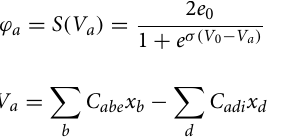
M2 receptor subtype 9–11,43 . Meanwhile, the SC population in the brainstem sends excitatory outputs to the TRC and IN populations via glutamatergic neurotransmitter 40,41 . The synaptic interconnections between the thalamus and the cortex modules conform to the classical results as presented in the literatures 26,36,37 , i.e., all the popula- tions of TRC, IN and TRN in the thalamus region receive excitatory inputs from the PY population, on the same time, the TRC population sends excitatory outputs to all the populations of PY, eIN, fIN and sIN in the cortical region. In addition to the ascending synapses from the brainstem to the thalamus and cortex, there is important descending synapse pathway from the cortex to the brainstem in the central nervous system 44,45 . Here, the PY population in the cortex module sends excitatory outputs to the SC and PNN populations in the brainstem module. Other extrinsic sources to the BTC model come from the retinal and nearby cortical formations, i.e., the retinal population sends excitatory outputs to the IN, TRC and SC populations, and the PY population receives excitatory afferent from nearby cortical regions 26,28,29,36,37 . For convenience, neuron populations in this model are denoted by different lowercase letters s , d , i , t , n , h , p , f , l , r and c , which represent populations SC, PNN, IN, TRC, TRN, eIN, PY, fIN, sIN, Ret, Cor, respectively. According to the technique of neural mass model, the kinetic equations governing each population are obtained by performing two mathematical operations. One is that the average membrane potential V a in each population a (here a = s , d , i , t , n , h , p , f , l , r , c ) receiving from all afferent neuronal populations is changed into an average density of spikes ϕ a , which is usually simulated by the following sigmoidal function: